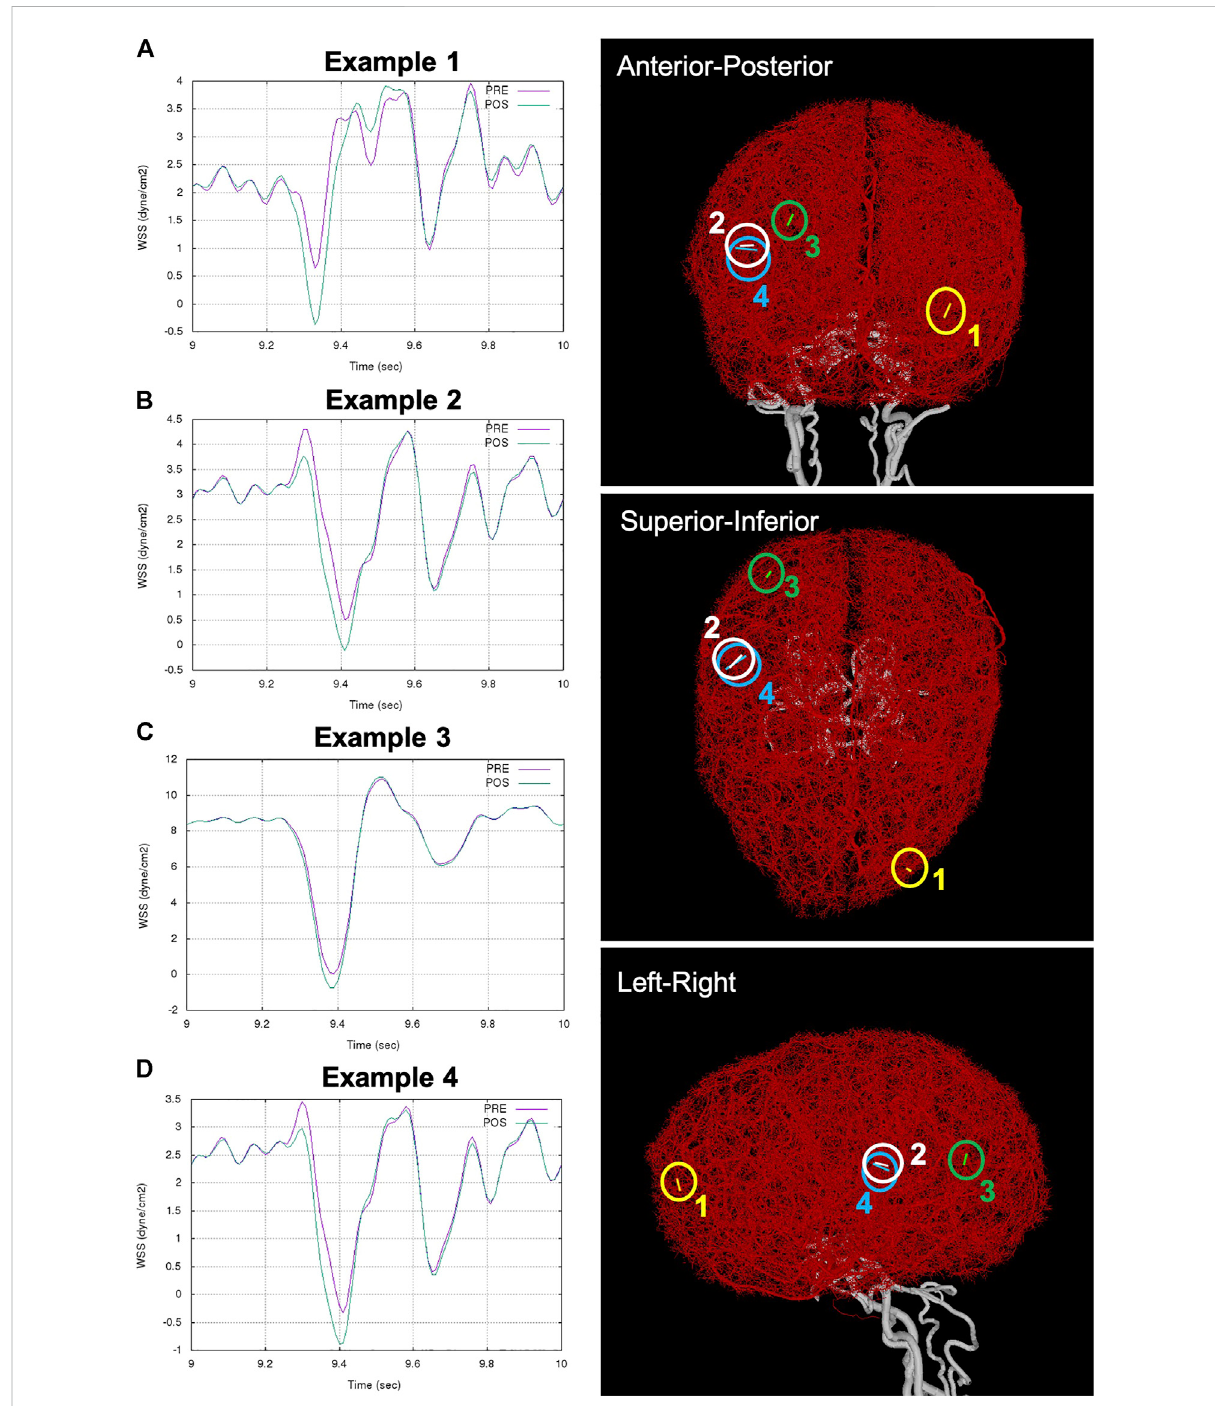
FIGURE 5 Examples of fl ow reversal in distal collaterals: (A) Example 1: WSS in collateral between left MCA and ACA trees (ipsilateral to aneurysm and FD), (B) Example 2: WSS in collateral between right MCA and PCA trees (contralateral to aneurysm and FD), (C) Example 3: WSS reversal in collateral betweenrightMCAandPCAtrees,and (D) Example4:accentuation of fl owreversalincollateralbetweenrightMCAandPCA.Anatomicallocationof the example collaterals (marked with circles and numbered) are shown on the right column in three orthogonal